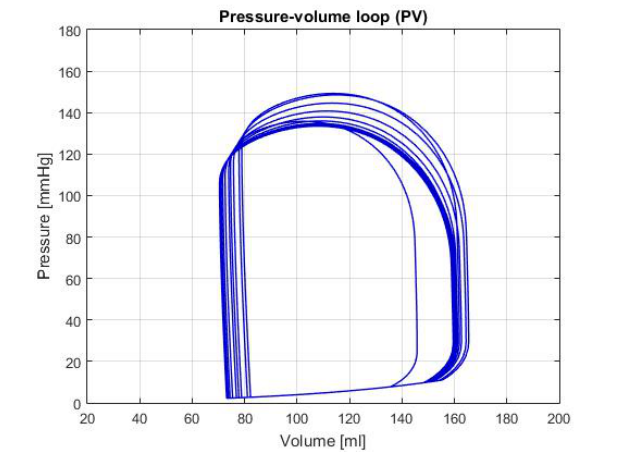
Figure 3. Graph of P-V loop curves with High Output Heart Failure (HOHF).